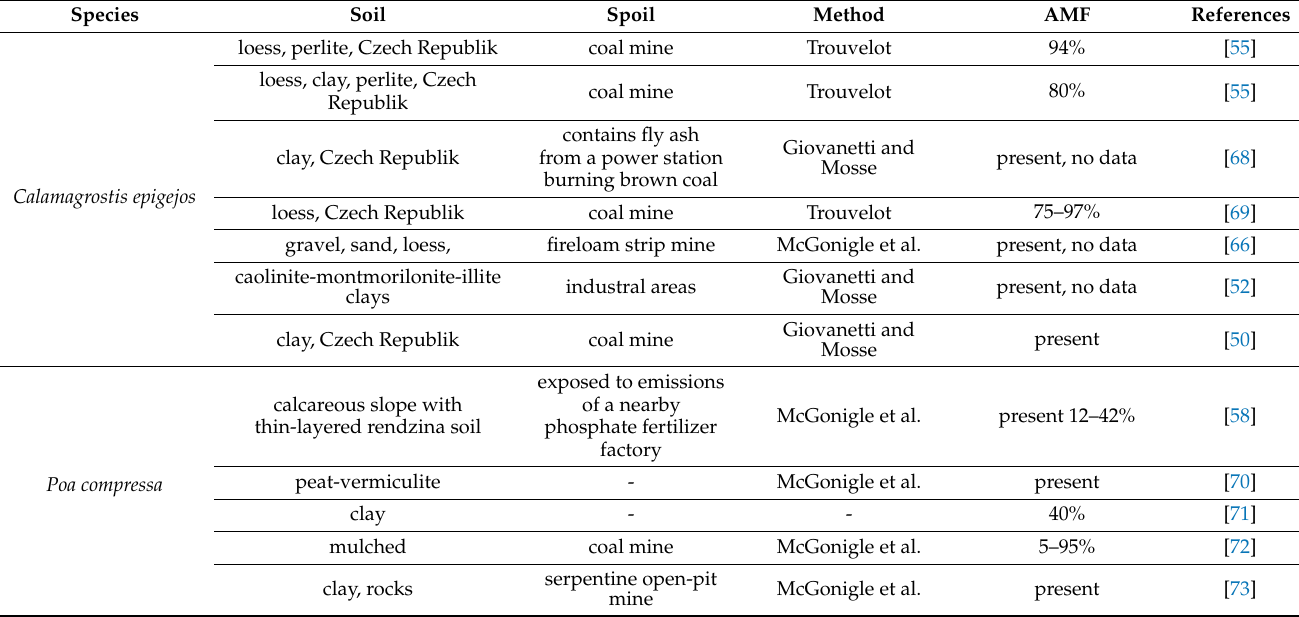
Table 4. The summary of the main results of the study conducted on Calamagrostis epigejos and Poa compressa and AMF colonization. Species Soil Spoil Method